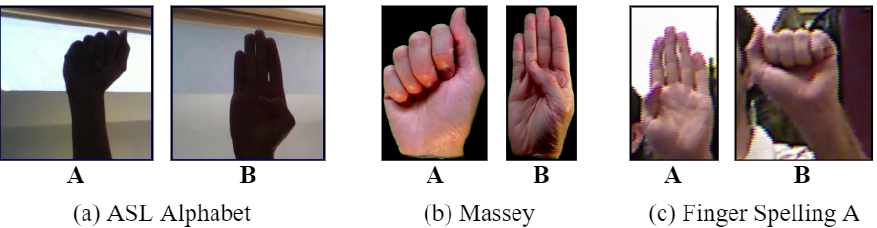
Figure 2. American sign language sample images for A and B from ASL alphabet ( a ), Massey ( b ) and finger spelling A ( c )